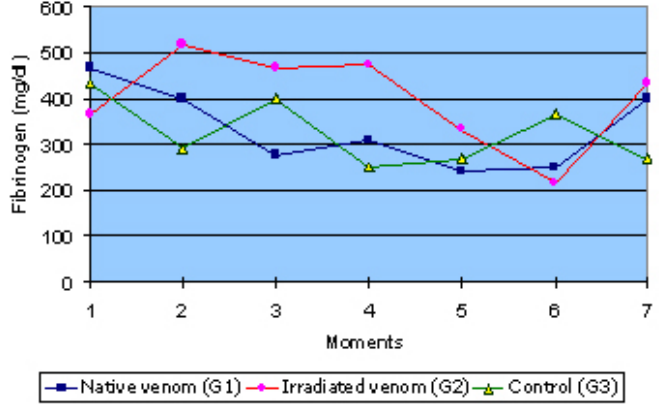
Figure 2: Mean values of total platelets count (103/µl) in ovine groups inoculated with natural (G1) and 60 Co- irradiated (G2) C.d.t. venom, and control group (G3), at different